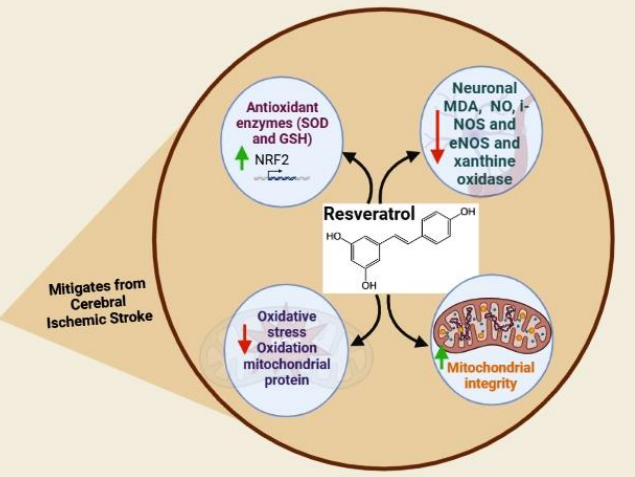
Figure 2. Effects of resveratrol on ischemic stroke (image created using biorender.com (accessed on 21 October 2022)).